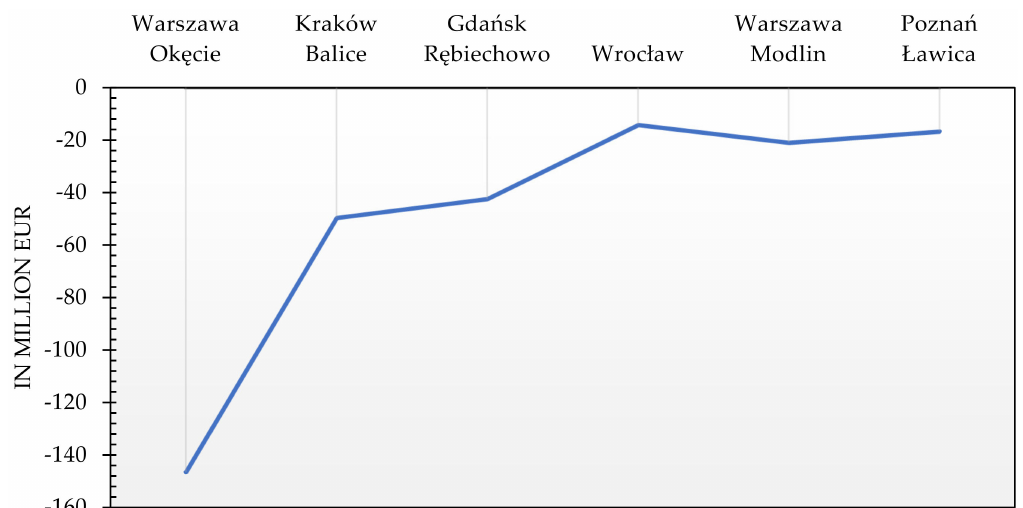
Figure 8. Average quarterly losses in millions of EUR.